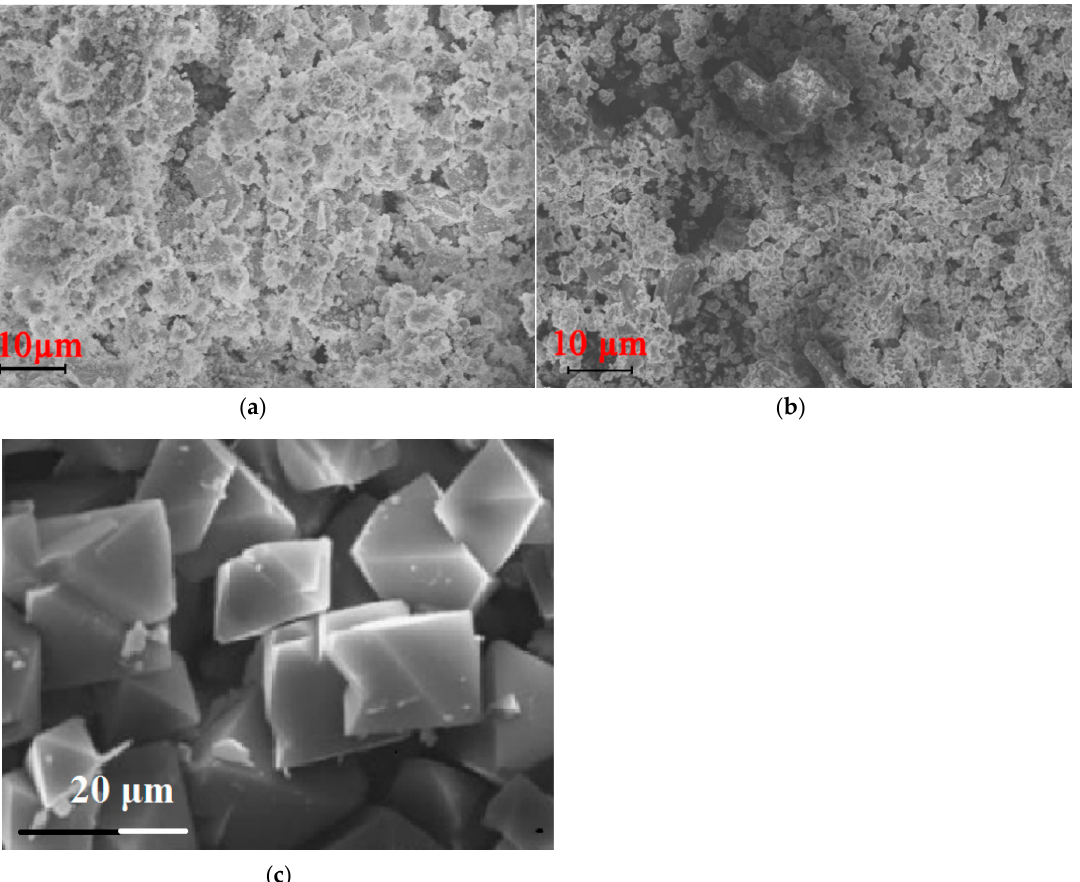
Figure 2. SEM images for MOFs synthesized according to the methods A ( a ), B ( b ), C ( c ).